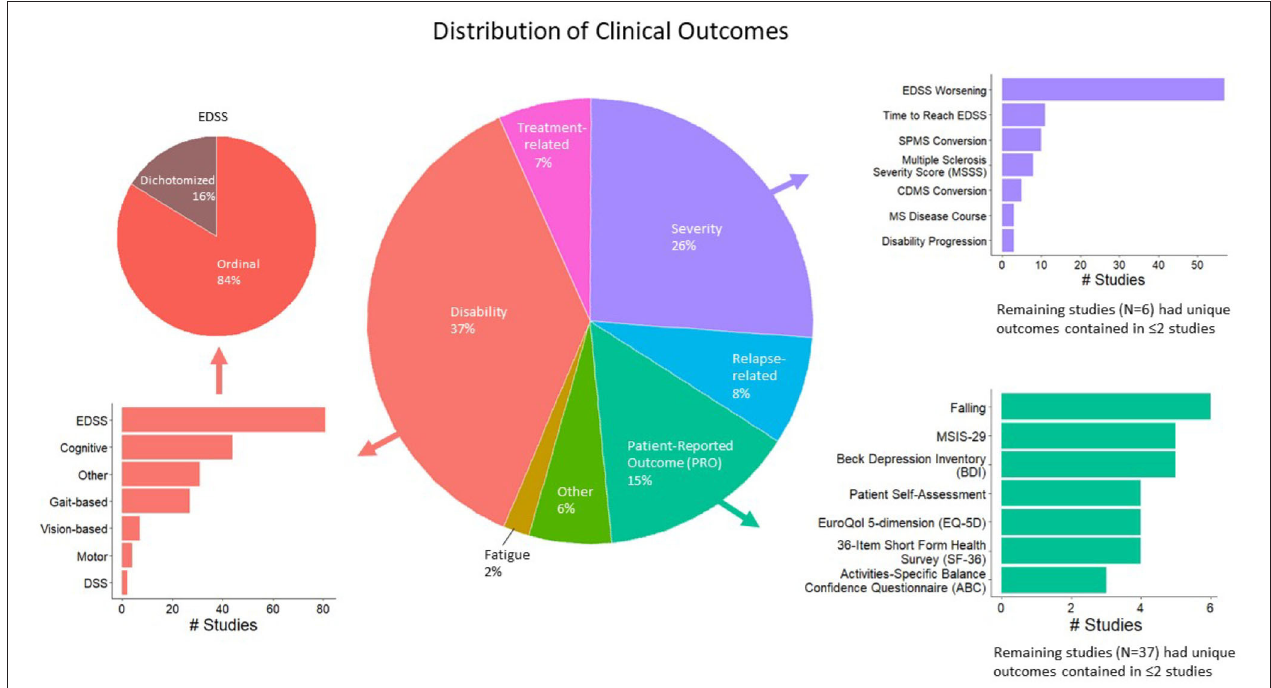
FIGURE 2 | Distribution of modeled clinical outcomes. The large pie chart in the center of the figure shows the distribution of categories of modeled outcomes. The three most frequent outcome categories are disability (37%, red), severity (26%, purple), and patient-reported outcomes (PROs; 15%, teal). The surrounding bar plots show the breakdown of each of these three